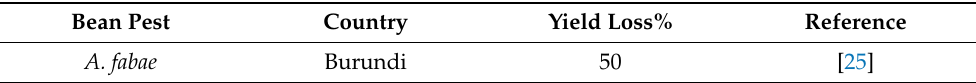
Table 1. The empirically assessed bean yield losses attributed to black bean aphid ( Aphis fabae ) and bean pod borer ( Maruca vitrata ) in East African countries per